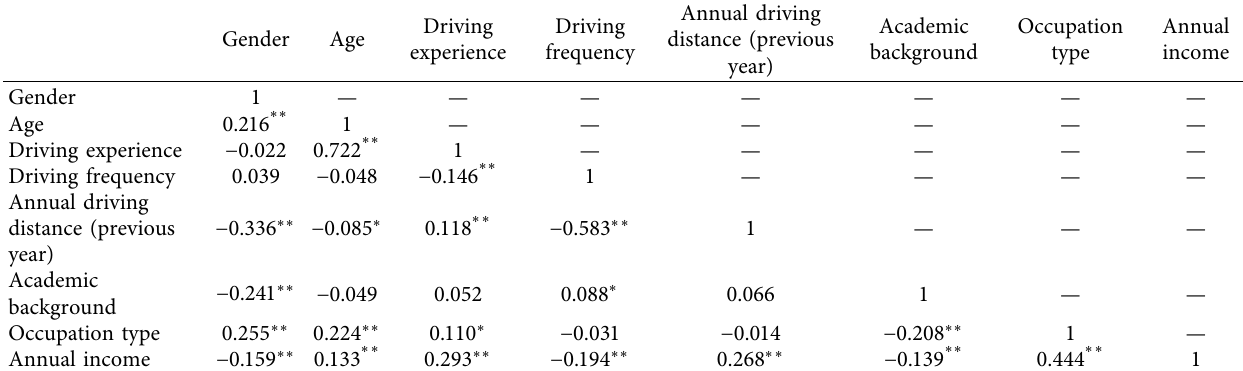
Table 13: Correlation coefficients among variables.